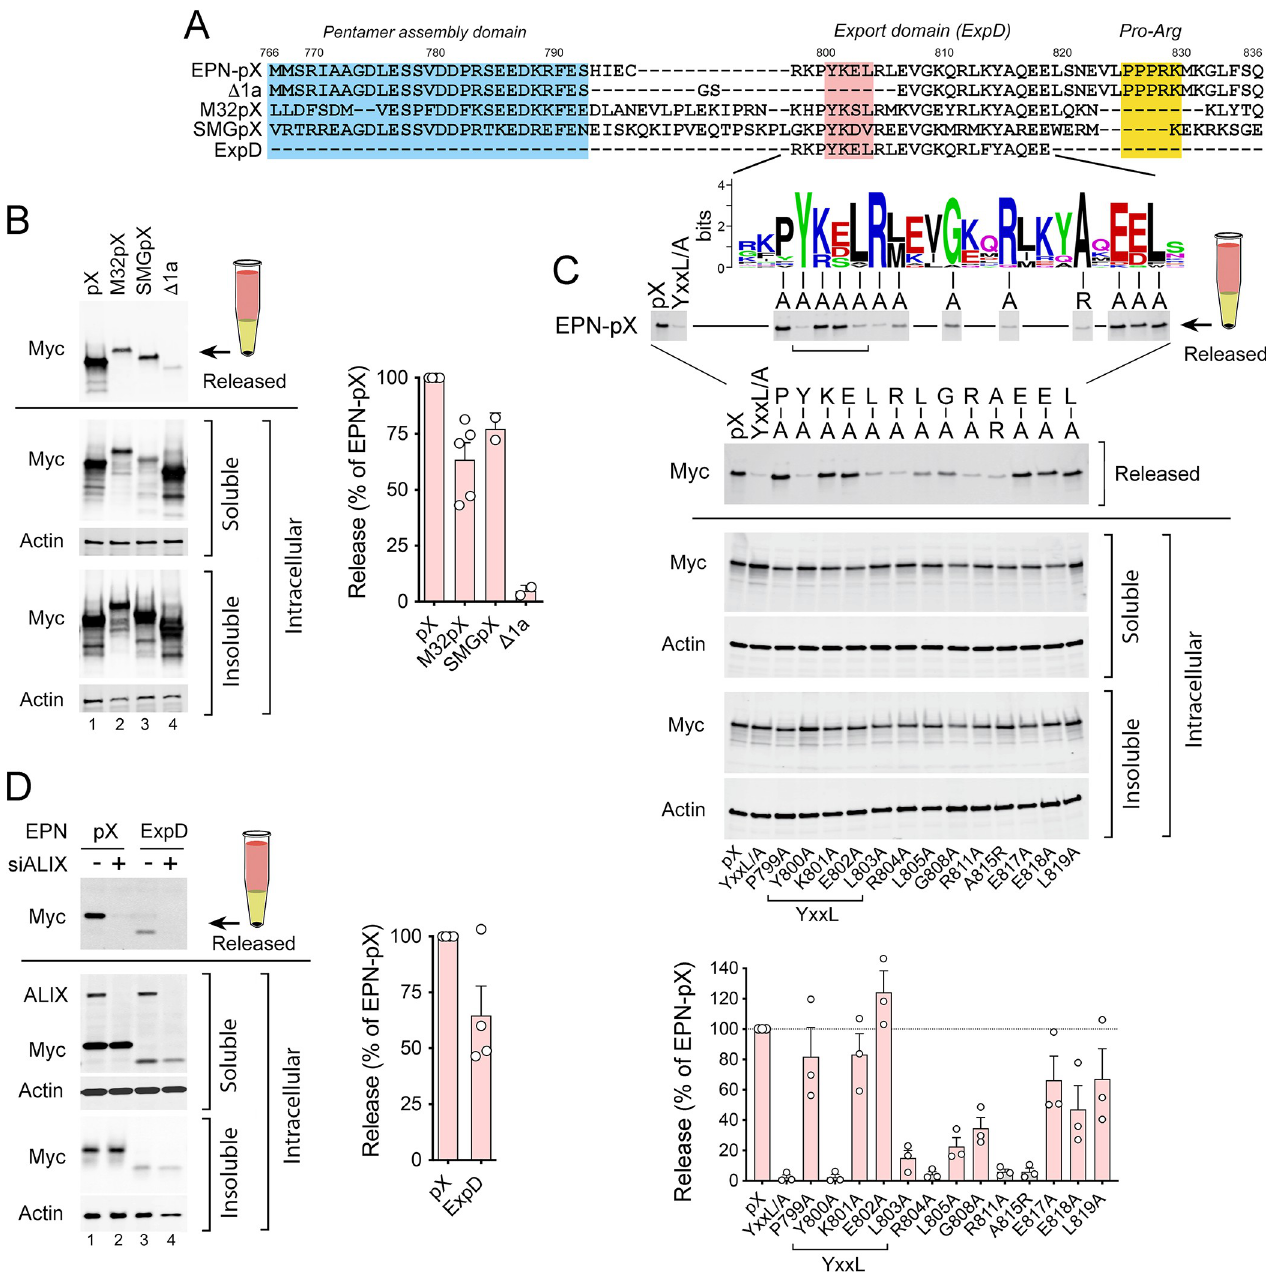
Fig 3. A conserved centrally-located pX peptide sequence, ExpD, mediates ALIX-dependent nanocage release. (A) Wild-type and mutant pX sequences of human p16 virus aligned with bat virus pX sequences of M32 ( Hepatovirus H ), recovered from Eidolon helvum , and SMG18520 (‘SMG’, Hepatovirus C ), recovered from Miniopterus manavi [39]. The N-terminal pentamer assembly domain is highlighted in blue, central ExpD sequence in red, and C-terminal Pro-Arg motif in yellow. Below is shown a WebLogo for ExpD derived from an alignment of 22 pX sequences from different mammalian hepatoviruses (see S3 Fig). Note that the Δ 1a deletion in the human pX sequence extends the Δ 1 deletion (Fig 2) to Leu805 with a GlySer insertion resulting from the cloning strategy. (B) Immunoblots showing released EPN-pX, EPN-M32pX, and EPN-SMGpX nanocages recovered from beneath a sucrose cushion, and related soluble and insoluble intracellular EPN proteins. EPN- Δ 1a was included as a negative control. Quantitation is shown on the right, with mean p16 and bat pX nanocage release normalized to intracellular protein expression, ± S.E.M., n = 2–5. (C) Alanine scanning of conserved amino acid residues within EPN-pX using the nanocage release assay. Shown below are immunoblots of released and intracellular EPN proteins, and at the bottom quantitation of immunoblots in 3 independent experiments. Brackets indicate residues within the YxxL motif. (D) Immunoblots showing released and soluble/insoluble intracellular EPN-pX and EPN-ExpD proteins following transfection with ALIX ( PDCD6IP )-targeting (+) or non-targeting (-) scrambled siRNAs. Immunoblotting of soluble intracellular proteins was with anti-Myc and anti-ALIX antibodies. Quantitation of EPN-ExpD release is shown on the right.